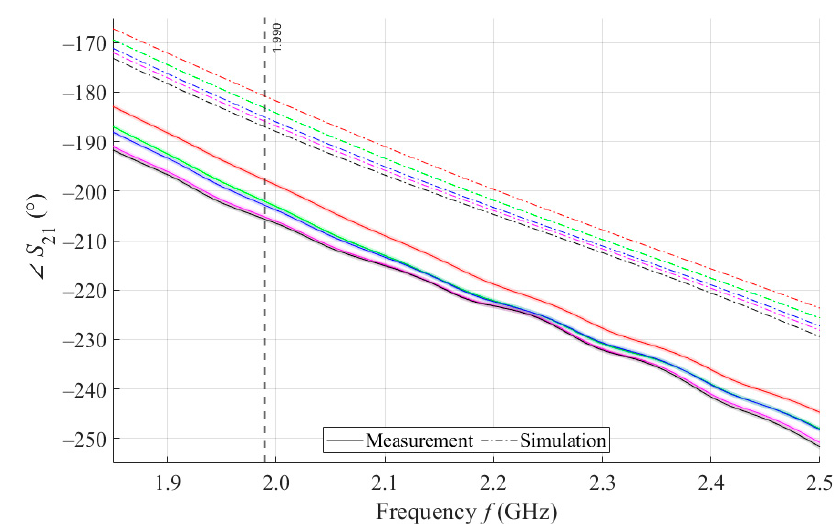
Figure 7. The course of ∠ S 21 for MSTL and 4 mL.